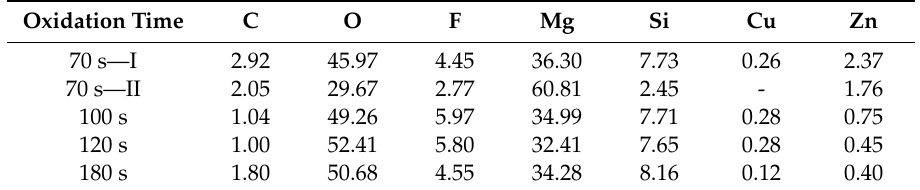
Figure 3. Surface morphologies of MAO–Cu 2 CO 3 (OH) 2 ·H 2 O coatings formed with different oxidation time on AZ91D magnesium alloy, ( a ) 70 s, ( b ) 100 s, ( c ) 120 s and ( d ) 180 s. Table 3. EDS results of MAO–Cu 2 CO 3 (OH) 2 ·H 2 O coatings formed with different oxidation time on AZ91D magnesium alloy (at. %).